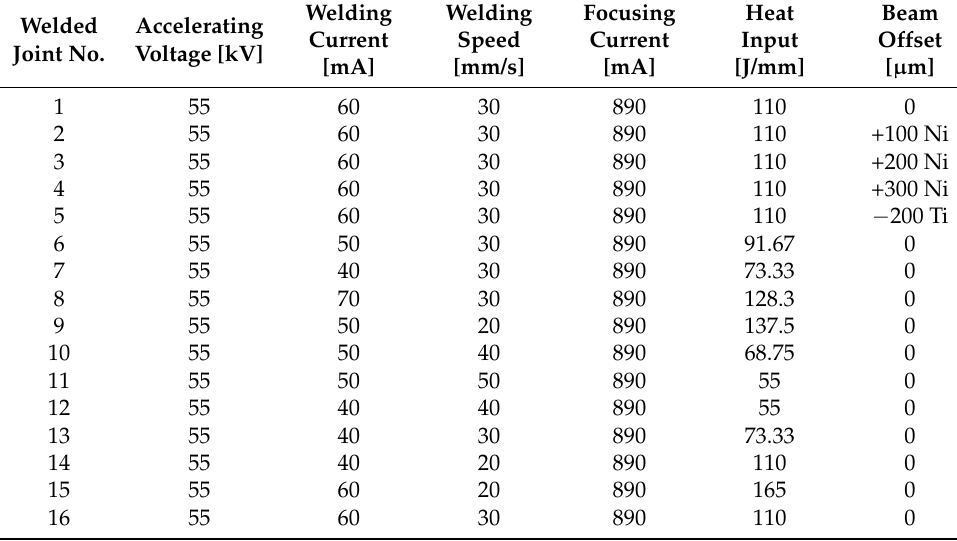
Table 6. Oscillation parameters.